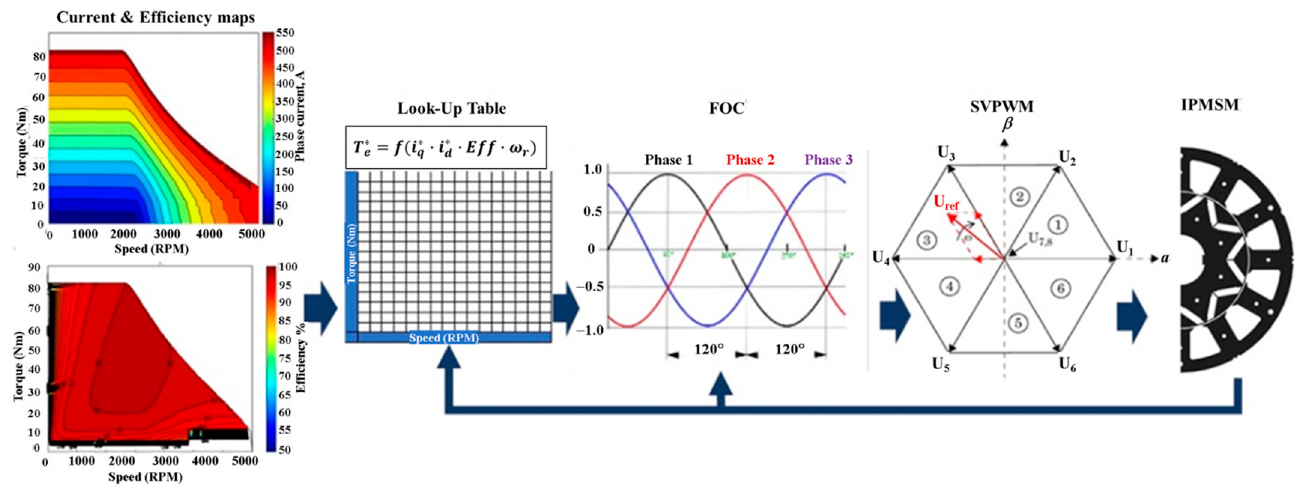
Figure 5. The proposed framework to control the IPMSM.